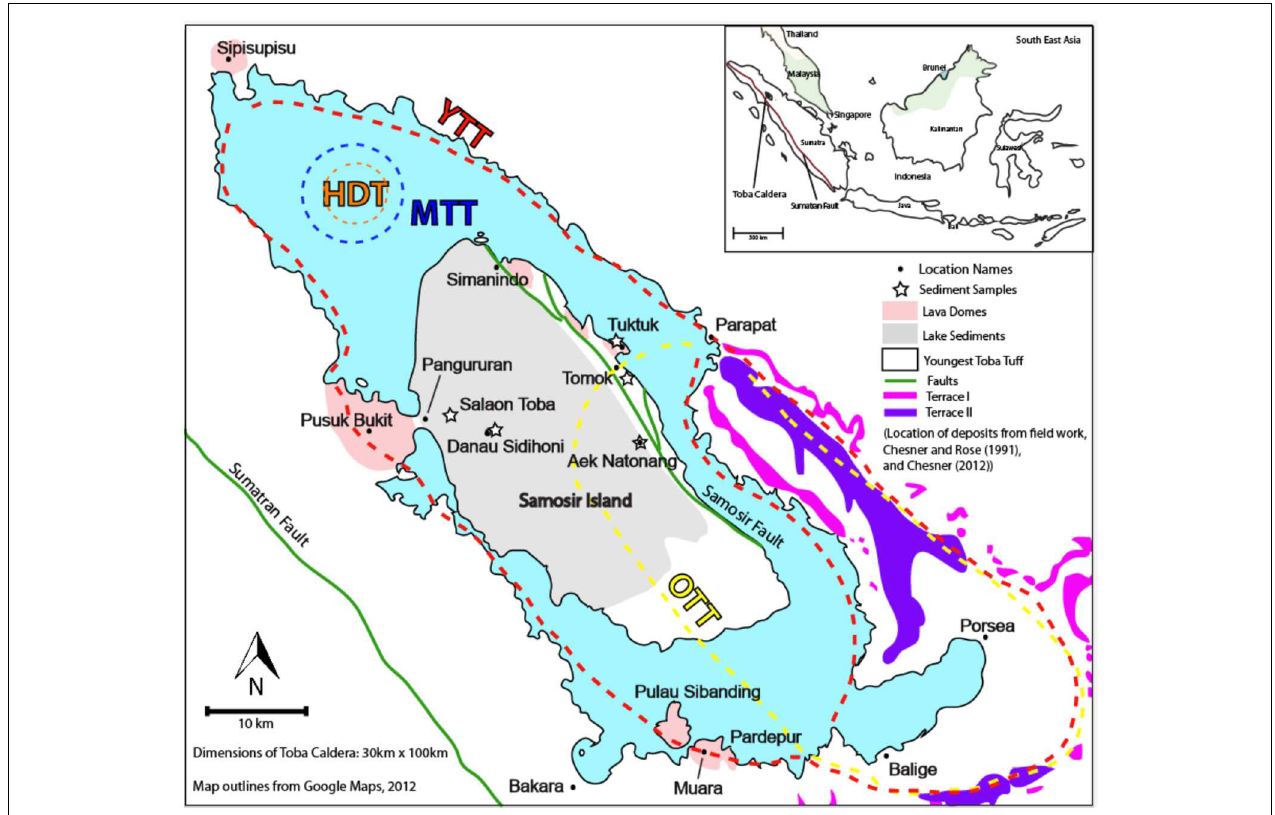
FIGURE 1 | Location map and main features of Toba Caldera, Sumatra that are discussed the text. Approximate caldera outlines for the various eruptions of Toba are taken from Chesner (2012). Location of 14 C samples in Table 1 and referred to in the text are shown. Inset shows the location of